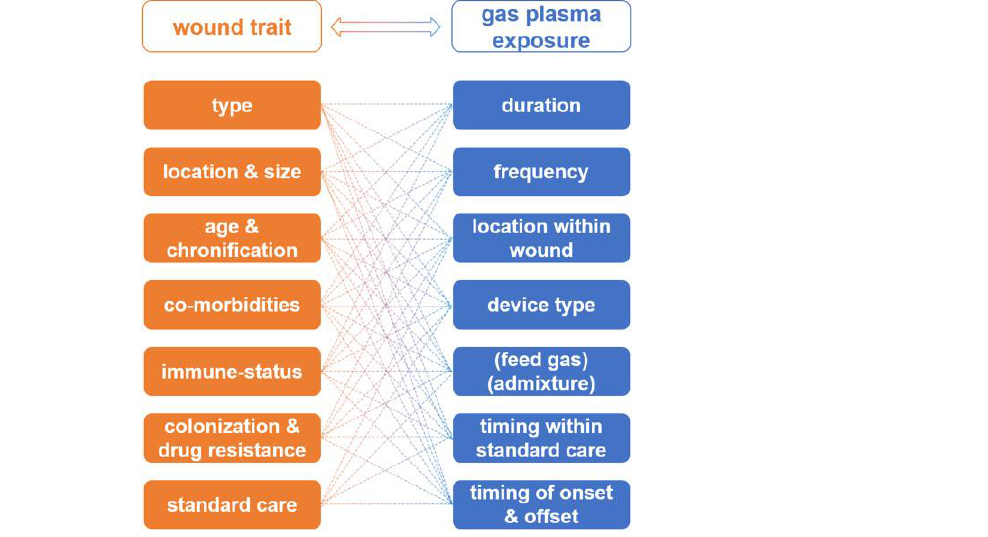
Figure 7. The interdependency of wound characteristics and gas plasma therapeutic schemes [62].